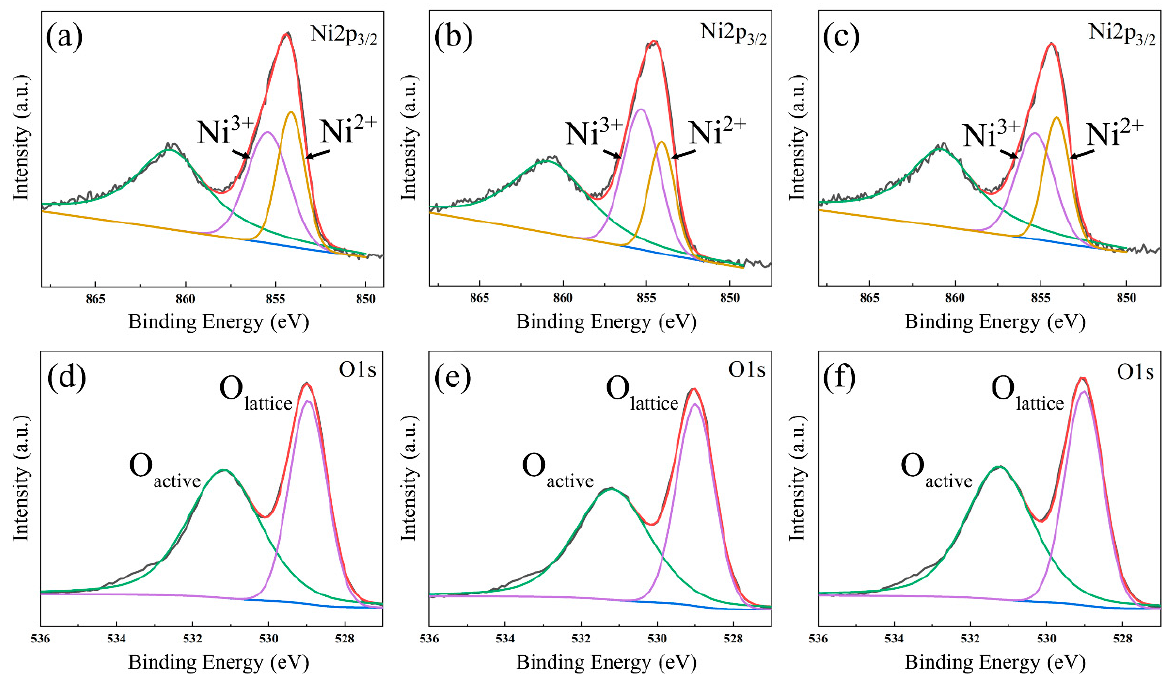
Figure 4. XPS spectra of Ni2p and O1s ( a , d ) NCM750, ( b , e ) NCM800, and ( c , f ) NCM850. SEM-EDX mapping diagrams are shown in Figure 5. The elements of Ni (red), Co (green), and Mn (purple) present uniform distributions on the surface of micron-sized monodisperse particles. Then, the atomic ratios of Ni:CO:Mn in the three samples were tested using SEM-EDX, as shown in Table S1. The data indicate that NCM800 is a stoichi- ometric sample, and there was a minor loss of Ni in NCM750 and NCM850. To further investigate the internal morphology of NCM800, TEM and high-resolution TEM images are shown in Figure 6. Figure 6a shows a low-magnification TEM image of NCM800, and Figure 6b shows a high-resolution image of the circled area in Figure 6a. Parallel lattice stripes can be observed in Figure 6b, and the width of the inter-planar spacing is 0.476 nm, which corresponds well with the (003) planes of the NCM structure. In addition, in the selected area electron diffraction (SAED) patterns are shown in Figure S2, a clear array of electron diffraction patterns rather than Debye rings can be observed, which confirms the single crystal properties of NCM800. Figure 5. EDX mapping images of ( a ) NCM750, ( b ) NCM800, and ( c ) NCM850.